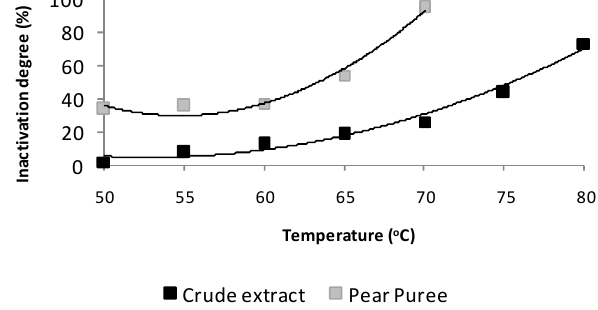
Fig. 4. Inactivation of PME crude extract and PME in pear purée by isothermal treatment for 5 min (black) and ohmic treatment at 25 V/cm for 3 min (grey) Table 2. Color measurements (CIELAB coordinates) of the pear purées before and after ohmic Parameter untreated treated 13.44 ± 1.22 BI (%) 32.5 ± 0.56 37.3 ± 1.30 * standard errors min -1 and a D -value of 256.4 min at 65 °C for banana PME. Espachs-Barroso et al. (2006) reported k value of 0.0161 ± 0.0013 min -1 at 66 °C and 0.549 ± 0.024 min -1 at 75 °C for purified banana PME.